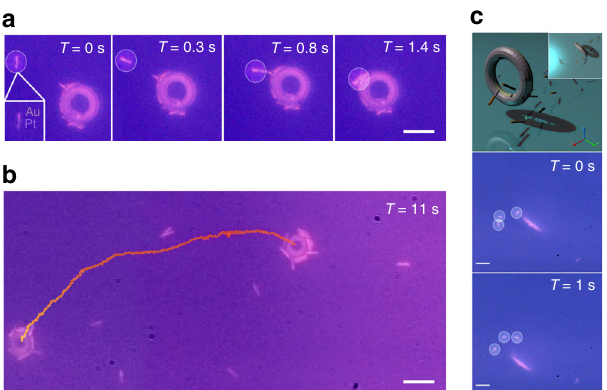
Fig. 6 Active cargo transport by swimming tori. a A timelapse showing the hydro- and electrodynamic attachment of a swimming bimetallic nanorod to a microtori. The scale bar is 7 μ m. b A timelapse showing a 3 μ m diameter tori transporting numerous bimetallic nanorods. The scale bar is 2.5 μ m. c A cartoon showing the vertical orientation of the micoscopic tori relative to the bimetallic nanorods near the surface. The bimetallic nanorods align along the self-generated fl uid streamlines of the microscopic tori when nearby. The scale bar is 2.5 μ m